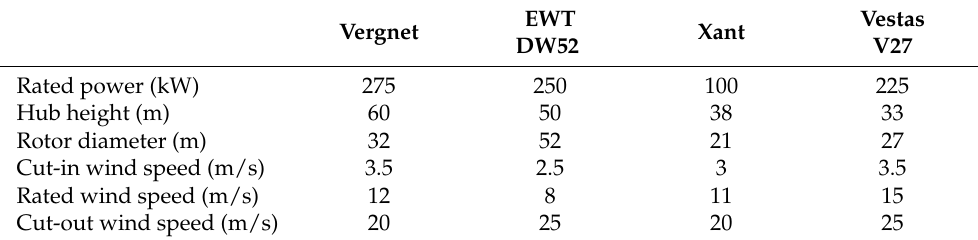
Table 2. Wind turbine